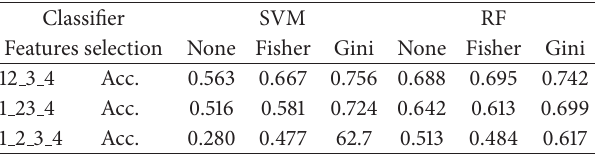
Table 4: Performance assessment (accuracy) for